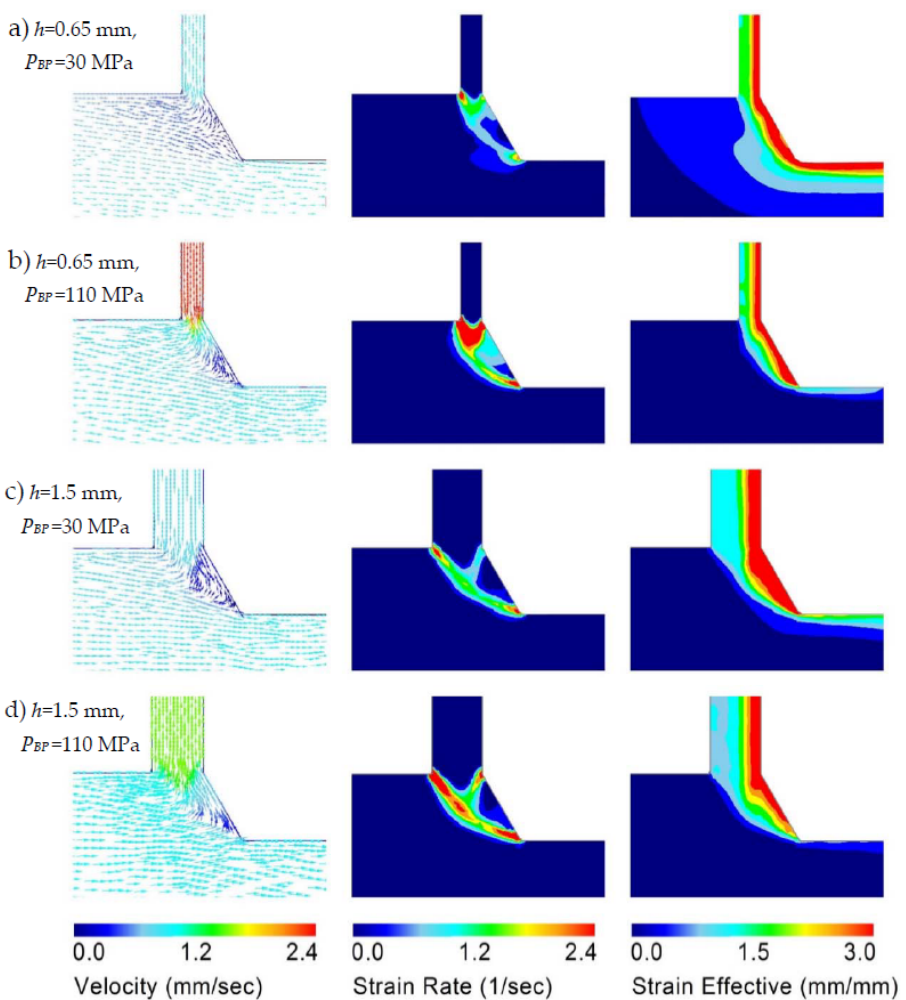
Figure 3. Results of finite element simulations of the PFM process for the parameters: H 0 = 20 mm; H 1 = 18 mm; α = 120°. The magnitudes of the velocity, strain rate, and effective strain (equivalent strain) are indicated by the respective color codes (the maximum value of the equivalent strain is about 4 in all cases).